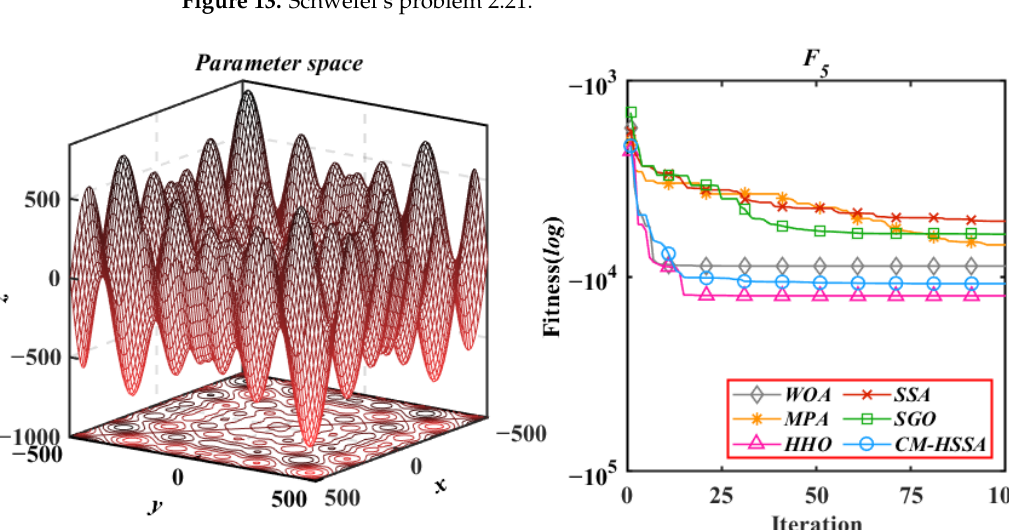
Figure 14. Generalized Schwefel’s problem 2.26.